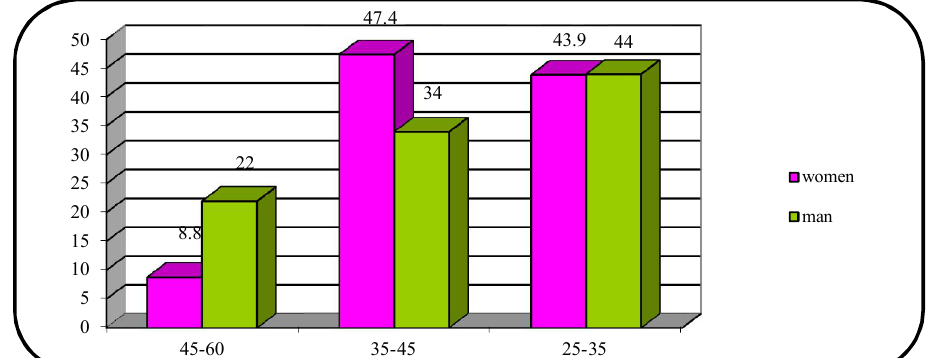
Fig. 4. The percentage of subjects in terms of